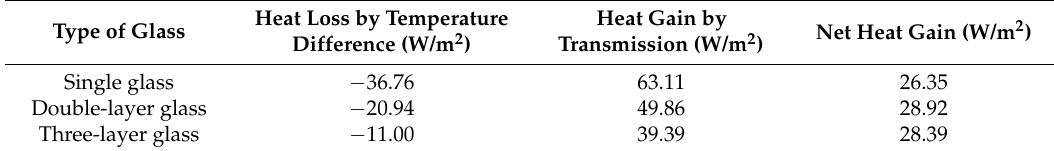
Table 1. Comparison of average accumulated thermal performance of different types of southward glass in the heating period (From 15th November to 15th next March) in Xi’an.